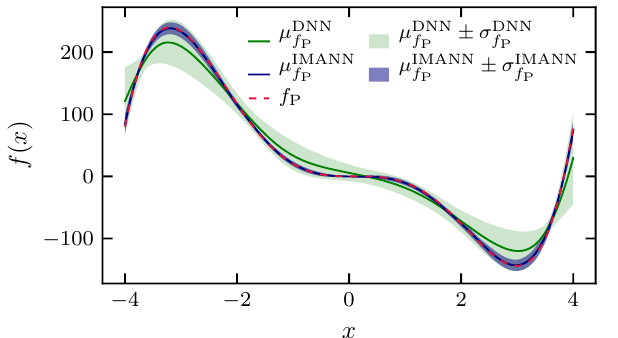
of a ˜ a and ˜ b subfunction made by IMANN with indicated one b regions. b